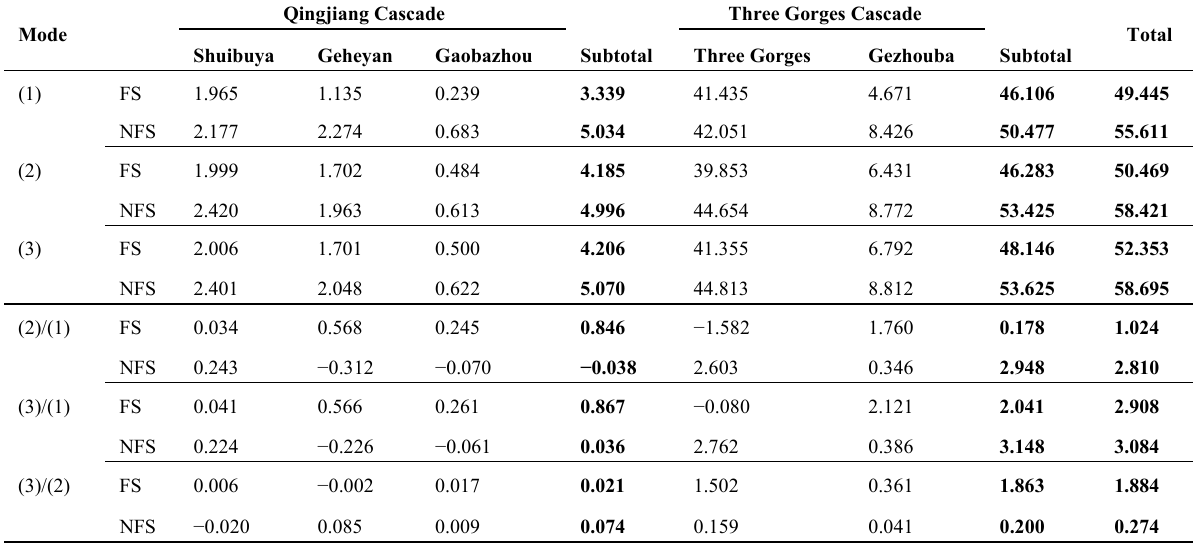
Table 3. Estimated hydropower generation (billion kWh) by objective function of maximum hydropower generation during flood season and non-flood season.